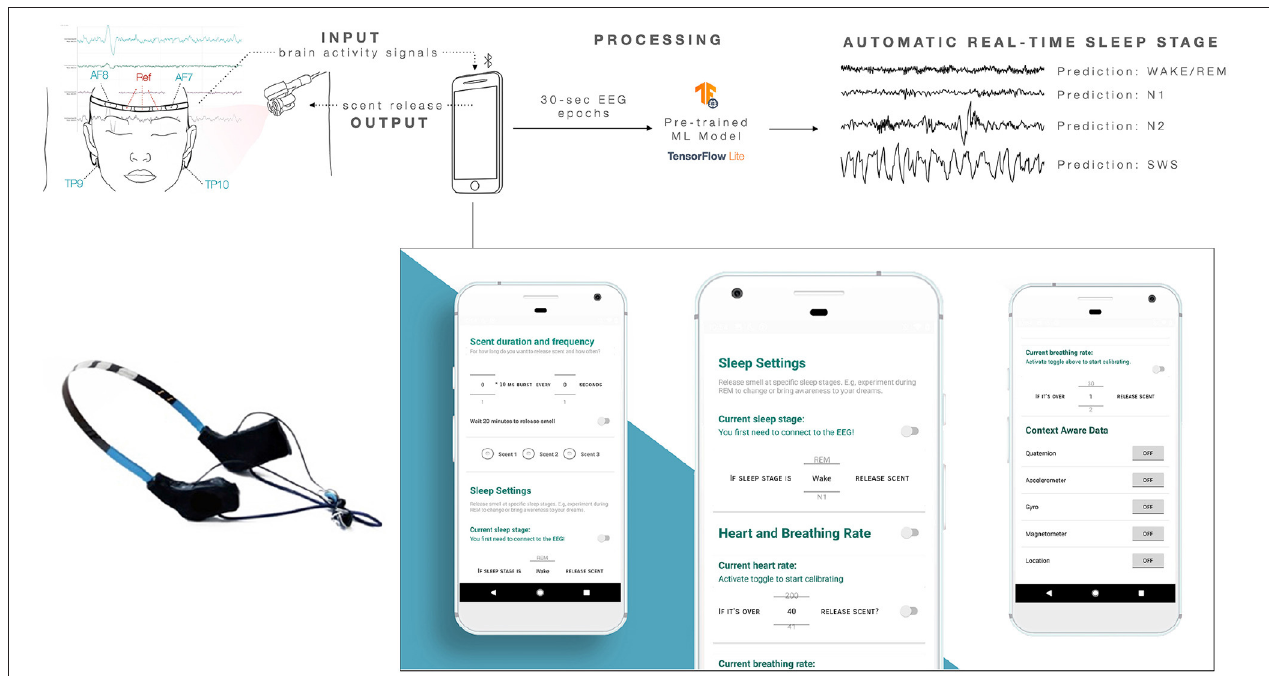
FIGURE 5 | The system reads brain activity signals and sends this information from the EEG to the smartphone via Bluetooth Low Energy (BLE). The app integrates a pre-trained machine learning model that takes 30 s worth of data from the EEG and predicts a sleep stage with a given accuracy. The user or experimenter can customize the duration and frequency of the olfactory stimulation in certain sleep stages using the smartphone app. Scent can be activated manually using a button, or automatically based on physiological signals, such as heart rate and breathing rate. The system can also release scent based on the user’s sleep stage, or based on time, e.g., 20 min after going to sleep.